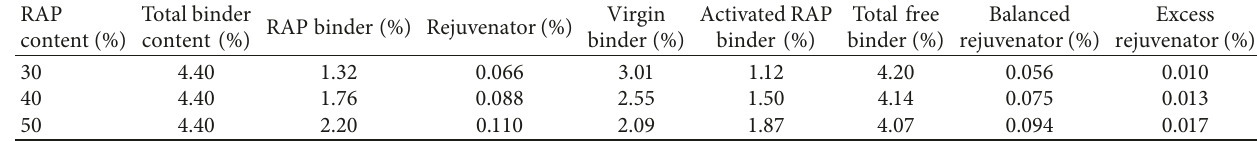
Table 13: Composition of binder in HMRAM with 85% DOB content.